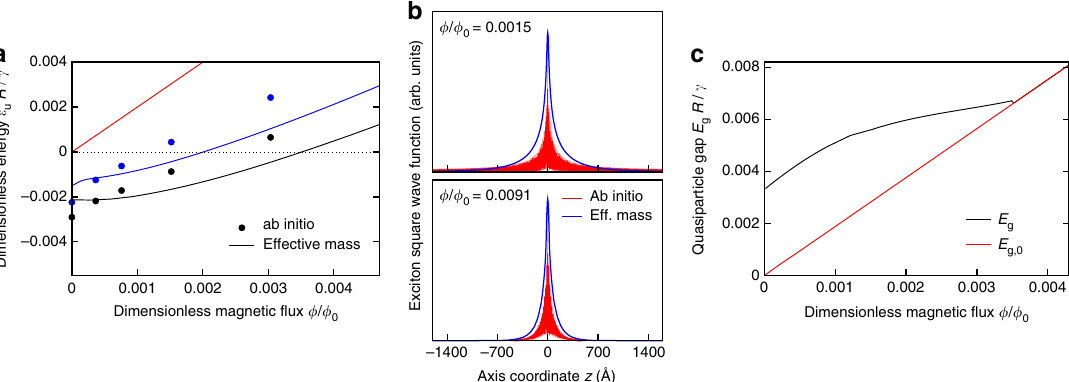
Fig. 6 Effect of an axial magnetic fi eld. a Excitation energies, ε u R / γ , of low-lying excitons vs magnetic fl ux, ϕ / ϕ 0 . Both fi rst-principles (dots) and effective- mass (solid lines) data are reported. The black (blue) color labels the triplet (singlet) spin symmetry. The red line is the noninteracting gap and the dashed line is the instability threshold. b Square modulus of the wave function of the lowest exciton vs e – h distance along the axis, z , for increasing values of magnetic fl ux. Both ab initio (red lines) and effective-mass (blue lines) data are reported. c Total quasiparticle gap E g R / γ vs ϕ / ϕ 0 . This observable may be accessed through Coulomb blockade spectroscopy. The red line is the noninteracting gap, E g